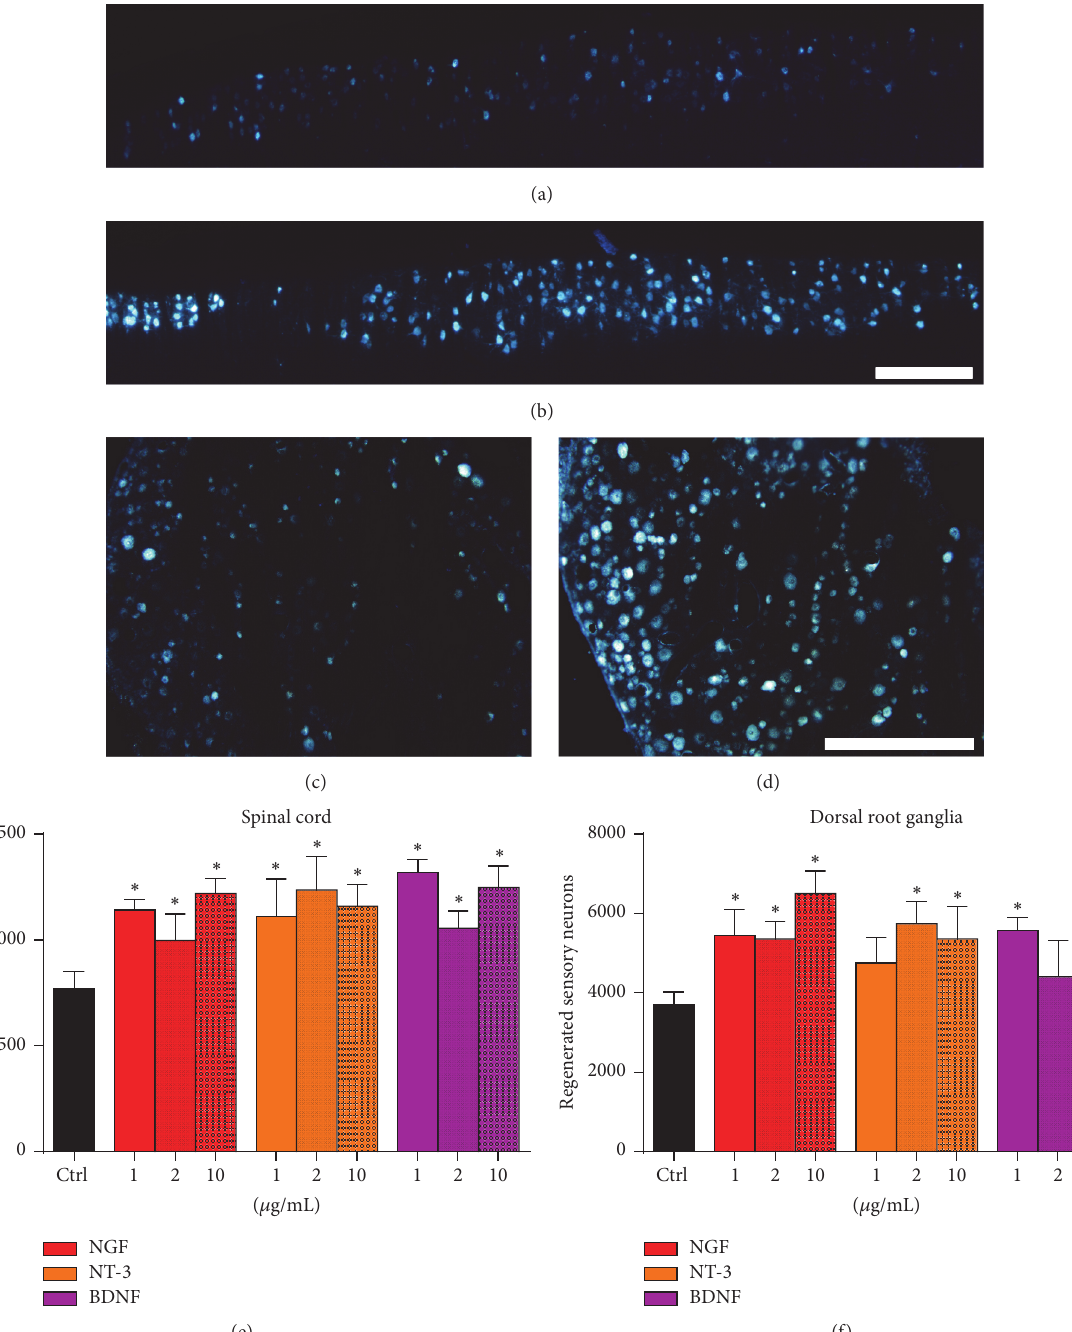
Figure 5: Representative micrographs of neurons retrolabeled with FG in the spinal cord (a, b) and DRG (c, d) growing in control conditions (a, c), with 10 𝜇 g/mL of BDNF (b) and 10 𝜇 g/mL of NGF (d). Histogram of the number of regenerated motor (e) and sensory (f) neurons after sciatic nerve section and conduit repair with NGF, NT-3, and BDNF at different doses. Data expressed as mean ± SEM. ∗ 𝑝 < 0.05 . Scale bar: 500 𝜇 m